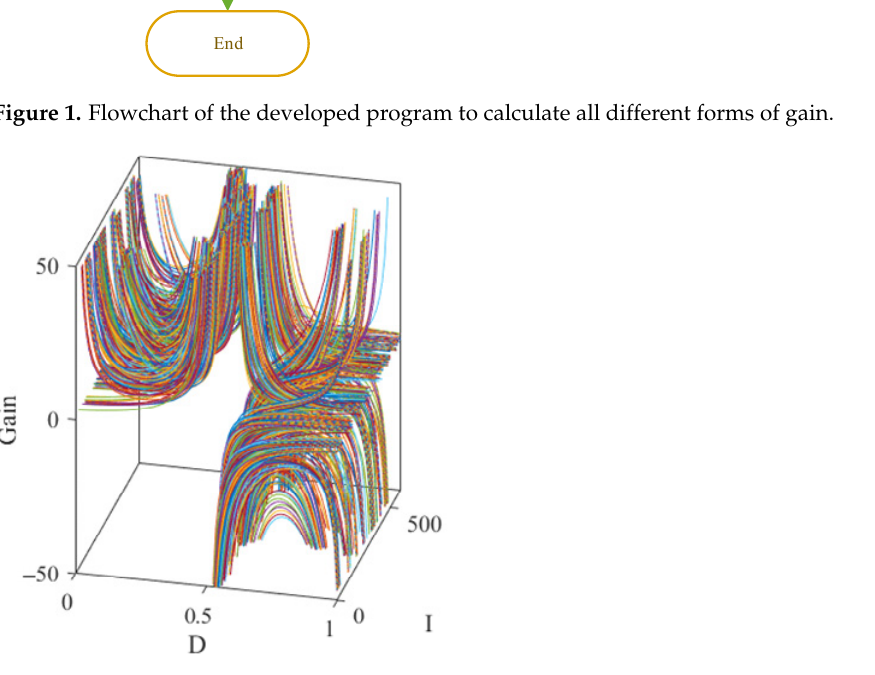
Figure 1. Flowchart of the developed program to calculate all different forms of gain.